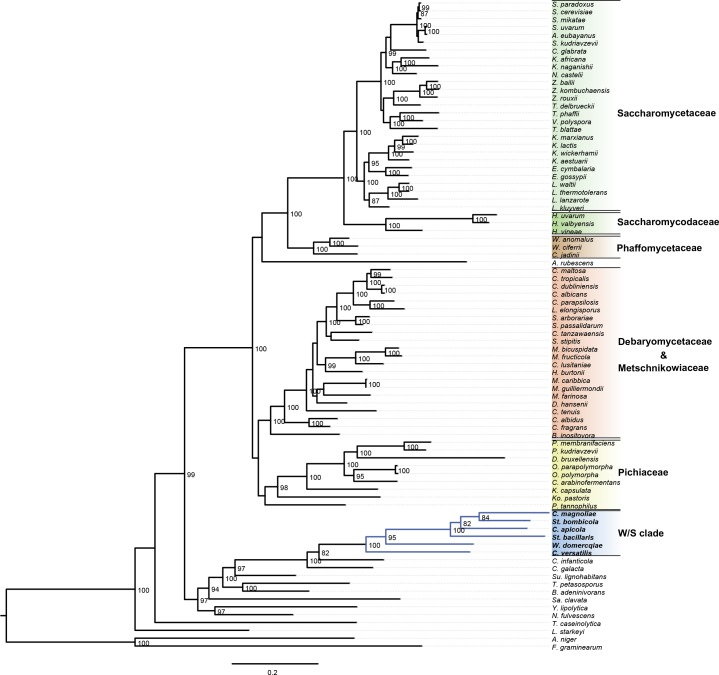
Complete ML phylogeny.